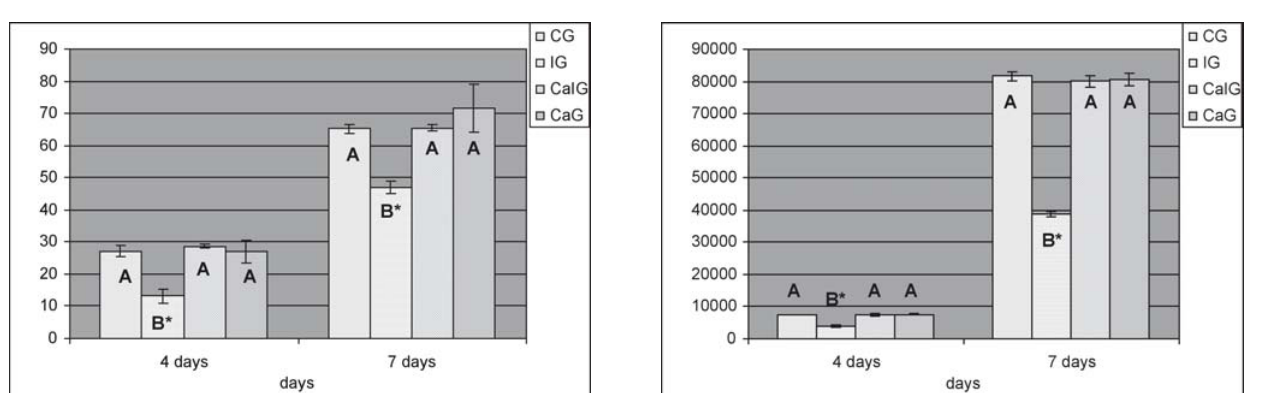
FIGURE 2- Means and standard deviation of the fibroblasts morphometry on the 4 th and 7 th of tissue evolution. Letters differ statistically between them, with significant p-value of 5%, by the Tukey test